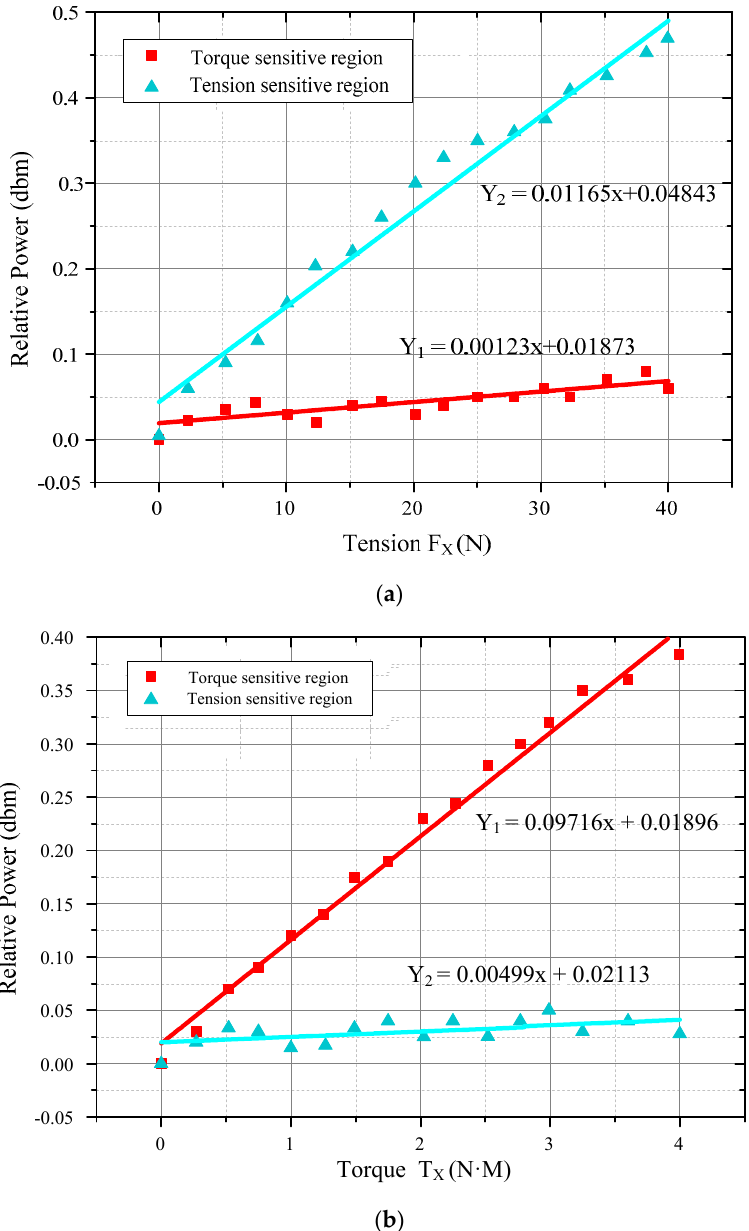
Figure 9. The output performance curve and linear fitting of the sensor: ( a ) output performance curve under tension and ( b ) output performance curve under torsion torque.